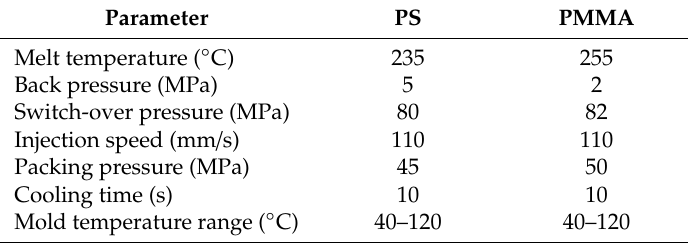
Table 4. Main processing conditions chosen for the injection molding experiments with the two resins.